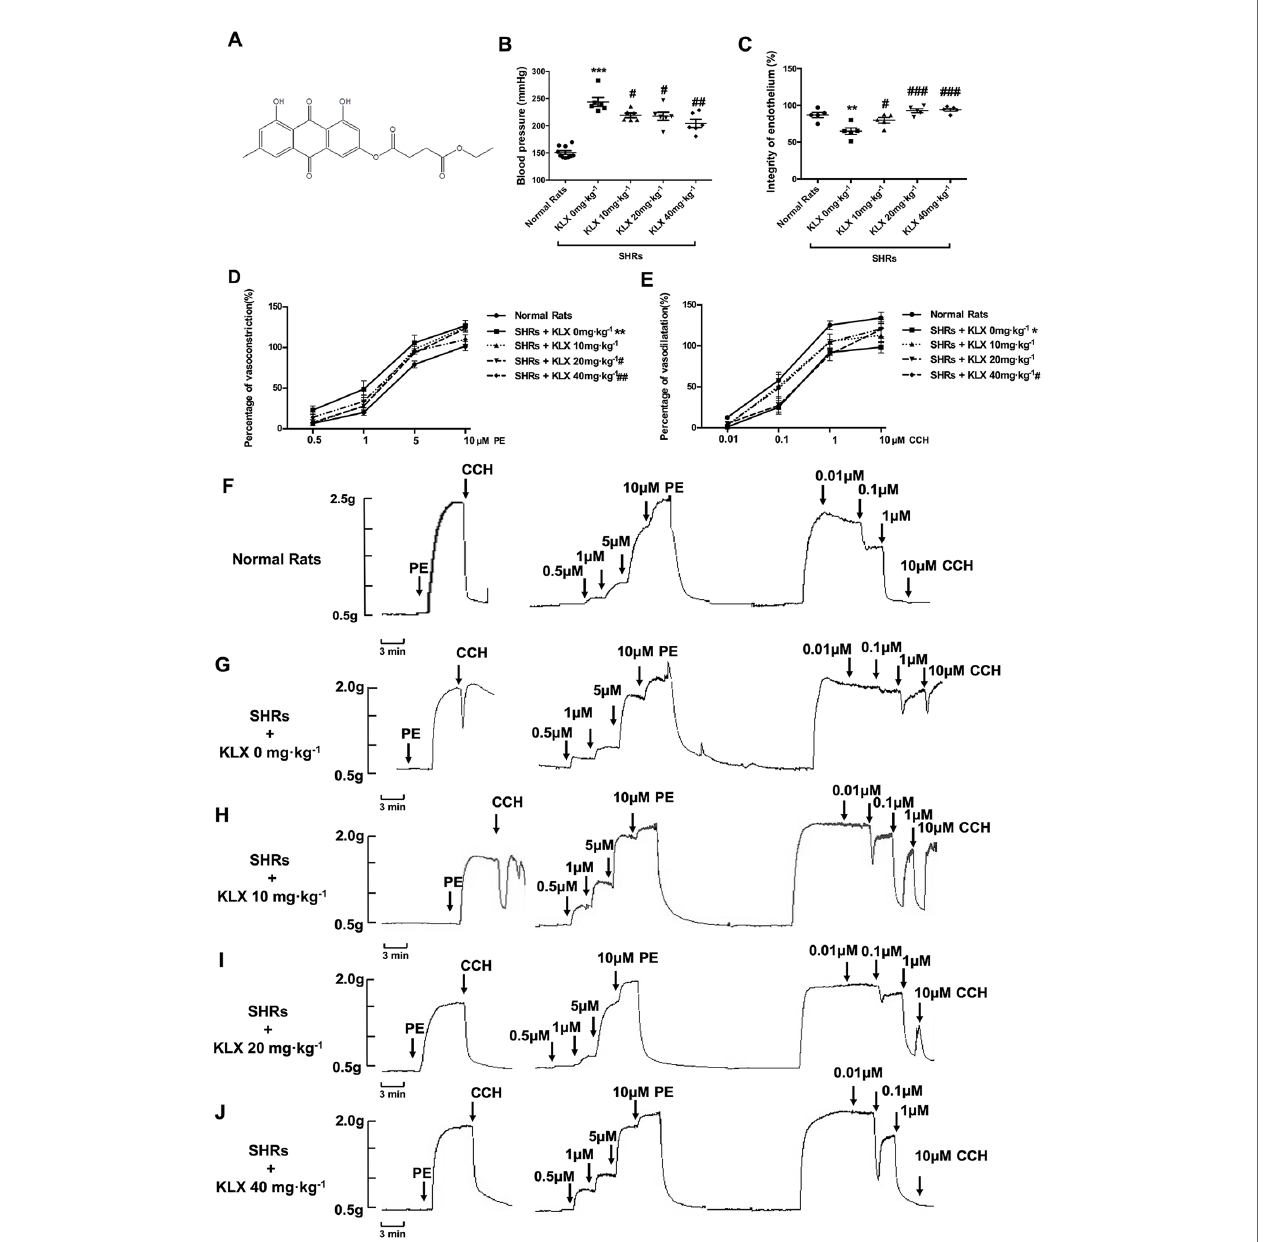
FIGURE 1 | KLX reduces arterial blood pressure and corrects the abnormal contractility of superior mesenteric artery (SMA). (A) Chemical structure of KLX. (B) Oral administration with KLX 10, 20, 40 mg·kg -1 for 2 weeks signi fi cantly reduced arterial blood pressure. (C) Oral administration with KLX 10, 20, 40 mg·kg -1 for 2 weeks signi fi cantly protected endothelial integrity. (D) KLX reduced the increased contractile reactivity of SMA in SHR. (E) KLX increased the decreased vasodilatory reactivity of SMA in SHR. (F) Representative vascular tension recording image showed the SMA reactivity of control rats responded to different concentrations of PE or CCH. (G) Representative vascular tension recording image showed the alterations of SMA reactivity of SHR in Model group responded to different concentrations of PE or CCH. (H) Representative vascular tension recording image showed the effects of KLX 10 mg·kg -1 on the SMA reactivity of SHR in response to different concentrations of PE or CCH. (I) Representative vascular tension recording image showed the effects of KLX 20 mg·kg -1 on SMA reactivity of SHR in response to different concentrations of PE or CCH. (J) Representative vascular tension recording image showed the effects of KLX 40 mg·kg -1 on SMA reactivity of SHR in response to different concentrations of PE or CCH. (F – J) are representative images of D and E. Data are presented as mean ± SEM, * p < 0.05, ** p < 0.01, *** p < 0.001 vs Control; # p < 0.05, ## p < 0.01, ### p < 0.001 vs Model, n =